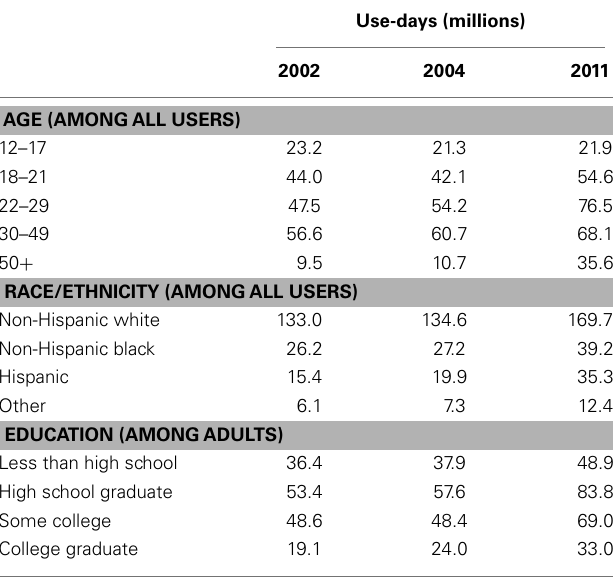
Table 4 | Cannabis past-month use-days (millions) by demographic groups over